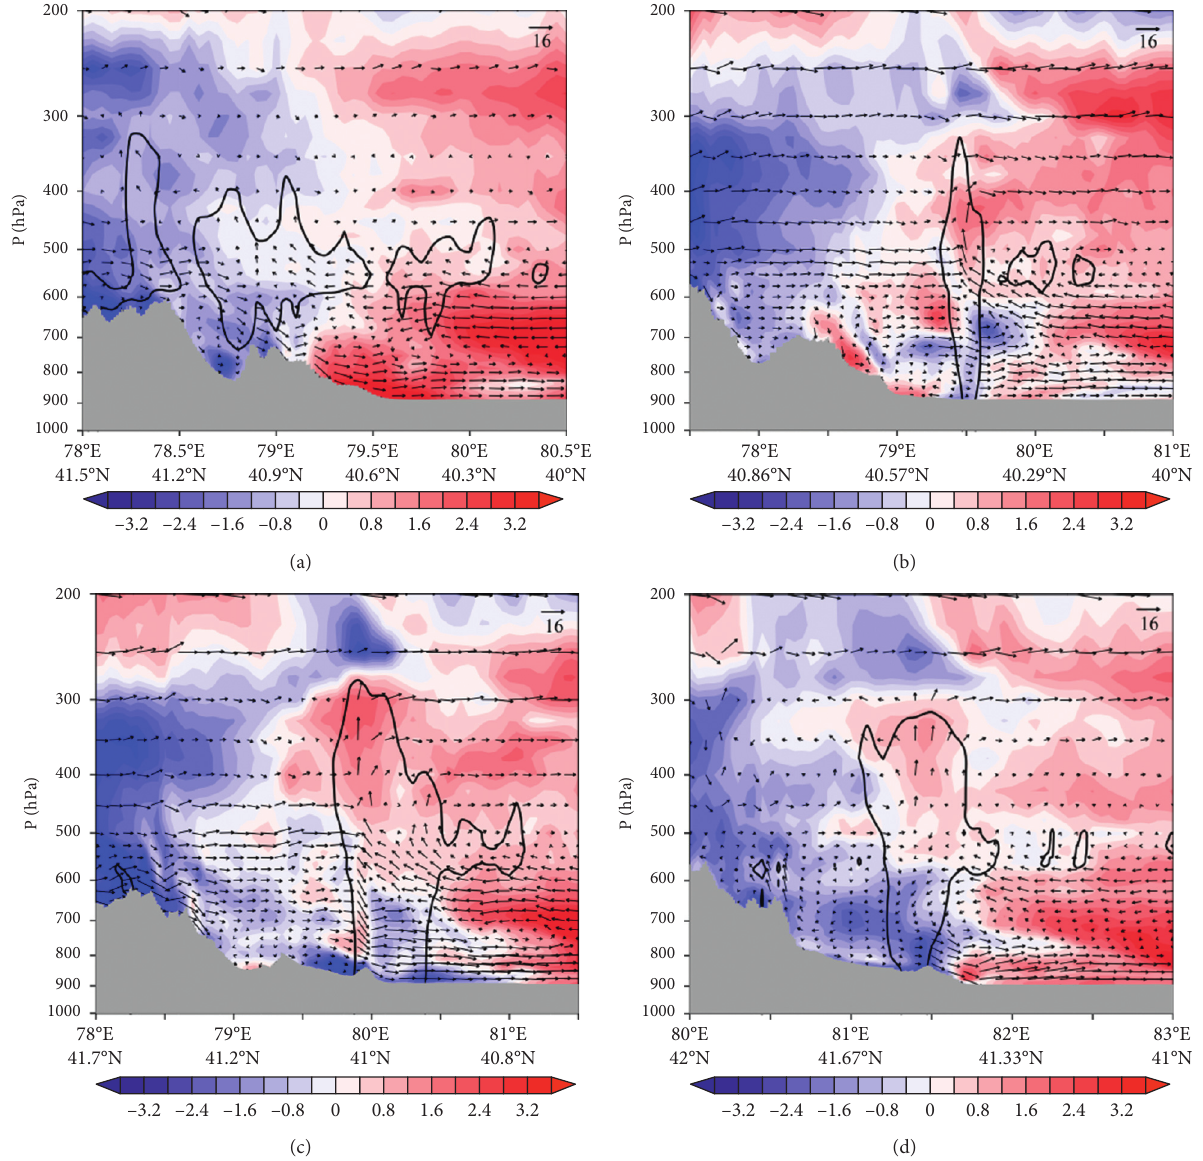
Figure 8: Vertical cross sections of simulated temperature disturbance (shaded, unit: ° C; the solid black line is the area where the echo was greater than 10 dBZ representing the rainstorm system, the same as below) along the black solid line CD shown in Figure 5. (a) Initiation stage at 12:00 on July 31. (b) Development stage at 16:00 on July 31. (c) Maturity stage at 17:30 on July 31. (d) Extinction stage at 22:00 on July 31,